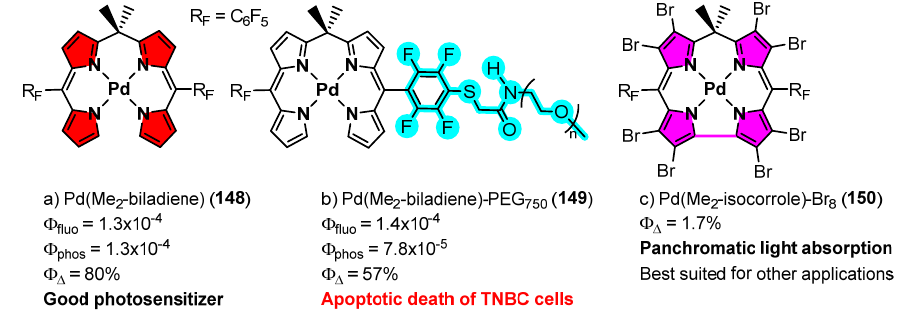
Figure 41. Different structural motifs based on Me 2 -biladiene and their most interesting photophysical properties. Adapted from [134–136].